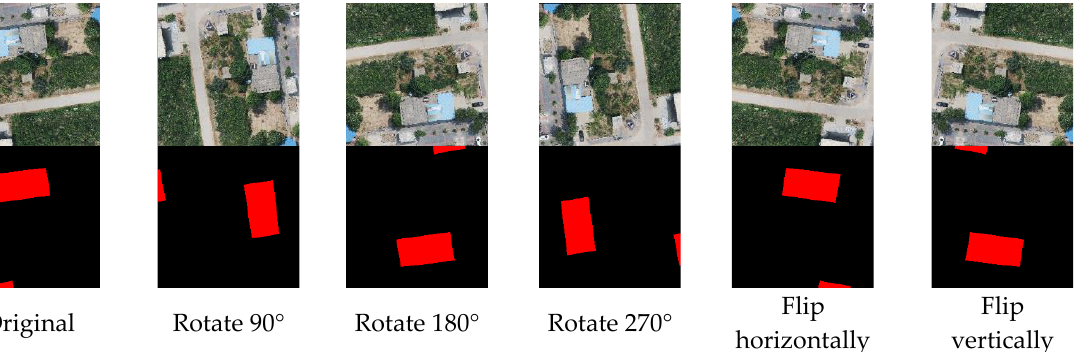
Figure 6. An example of data augmentation by rotating and flipping the rural Weinan building da- taset.